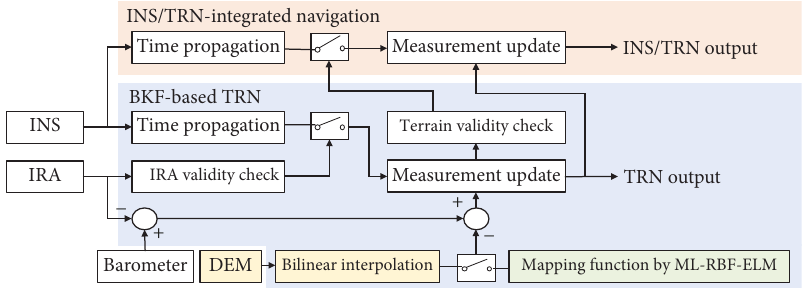
Figure 6: Schematic diagram of the TRN and INS/TRN system.